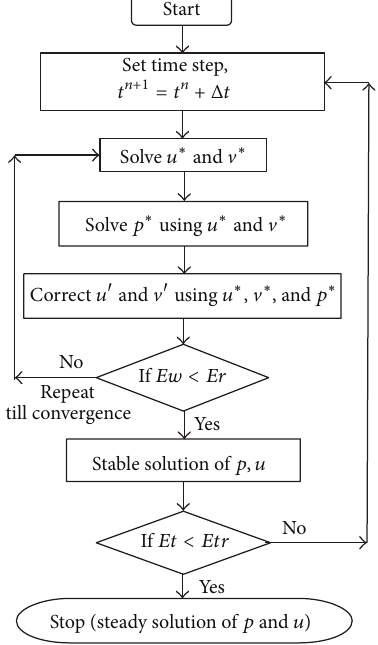
Figure 3: Flow chart of MAC